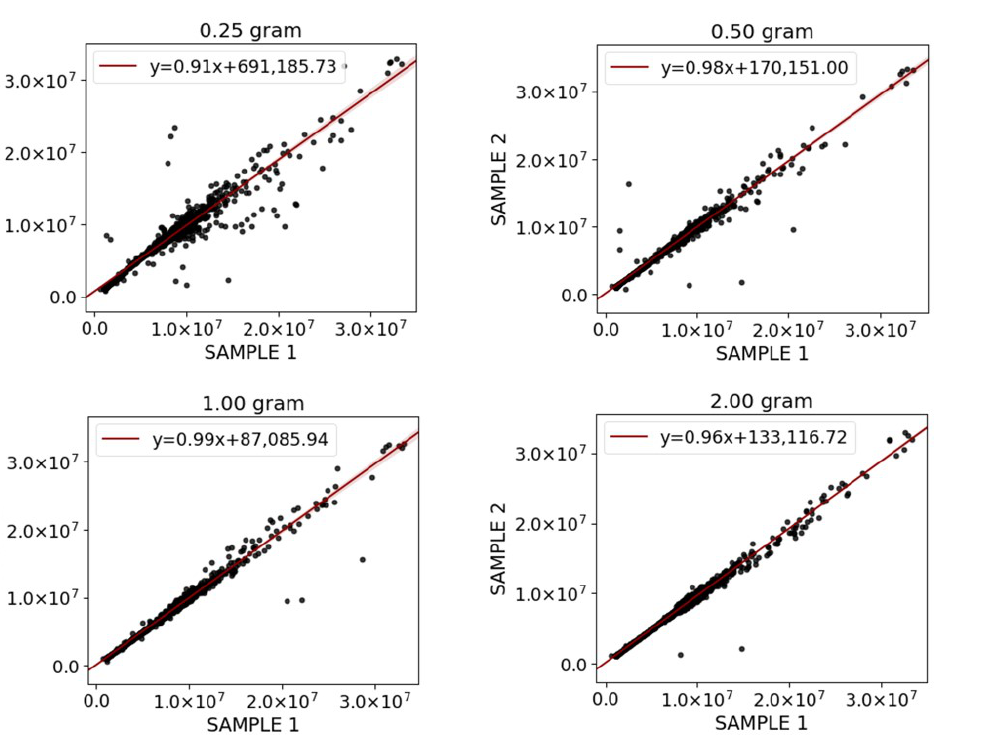
Figure 2. Effect of fecal amount (0.25, 0.50, 1.00 and 2.00 g) on feature intensities of two aliquots taken from the same homogenized fecal scoop. Black dots represent intensities of each feature. A linear relation between feature intensities of two subsamples from the same fecal scoop indicates a consistent representation of the